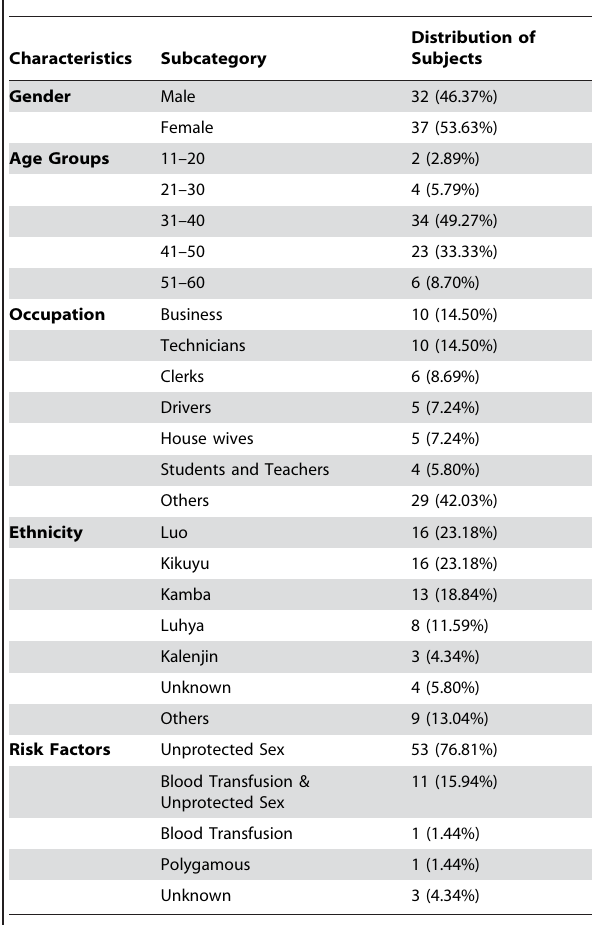
Table 1. Distribution of study subjects on the basis of gender, age, occupation, ethnicity and risk factors.